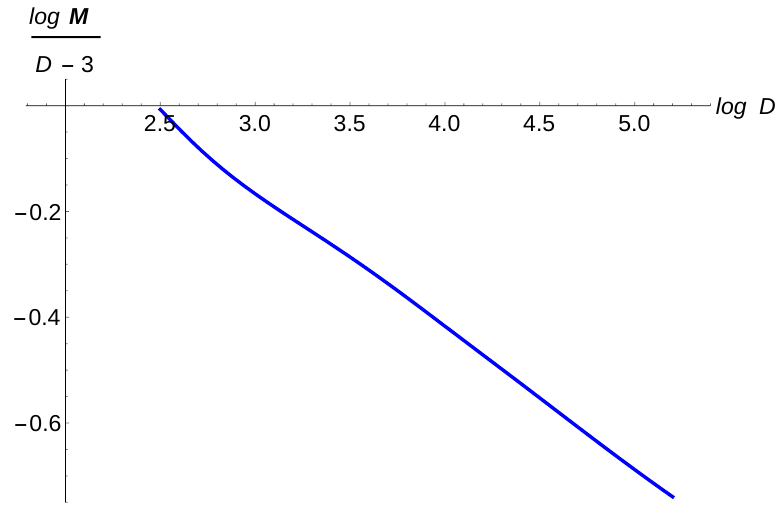
Figure 4 . Scaling behavior of the zero-tension curve M min ( D ) that we take as a proxy for the merger transition between static NUBS and BH phases. The curve (obtained at 4NLO) falls o(cid:11) as D (cid:0) 1 = 4 , in excellent agreement with the analytical estimate